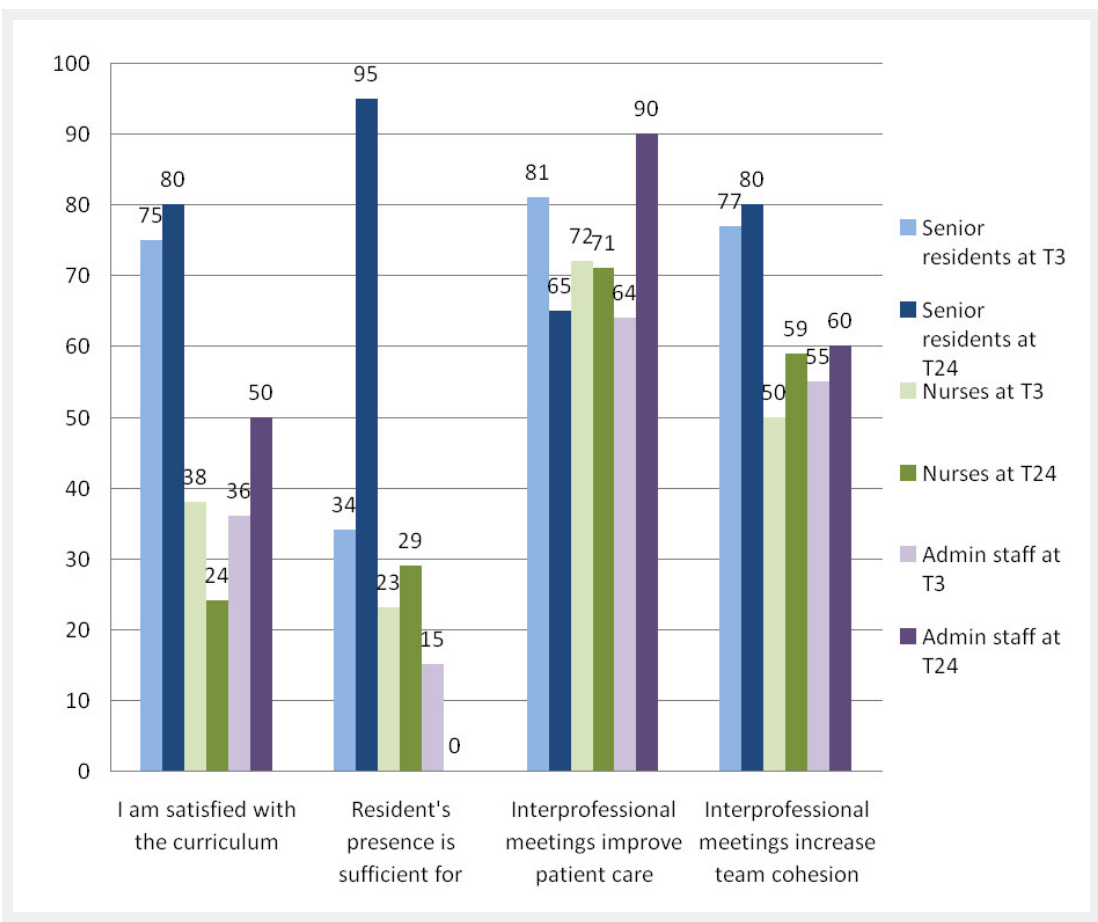
Figure 5 Evaluation of the new curriculum at 3 (T3) and 24 months (T24) by senior residents (clinical SV), nurses and administrative staff (expressed in %). Response rates: senior residents: n = 19 (43%) at T3 and n = 20 (44%) at T24; nurses: n = 28 (47%) at T3 and n = 17 (27%) at T24, administrative staff: n = 26 (87%) at T3 and n = 10 (50%) at